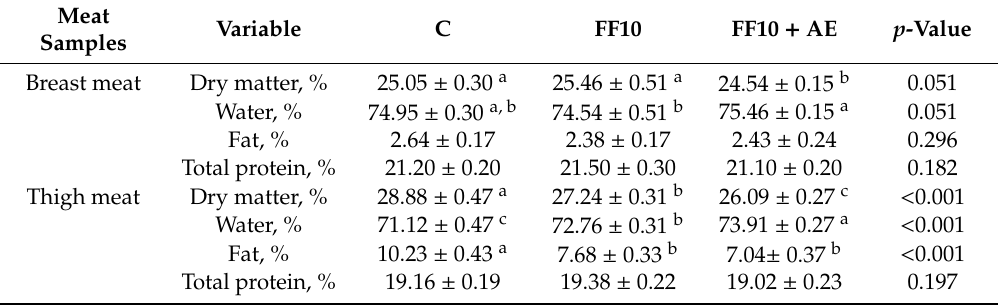
Table 6. The results of the chemical composition determination of breast meat samples (means ± SD).